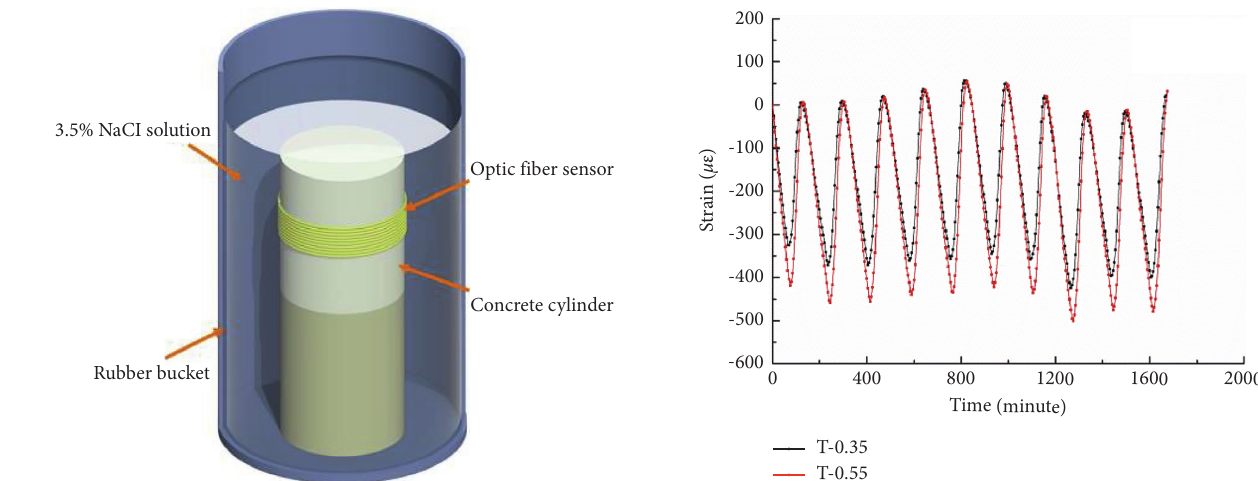
Figure 7: The strain behaviors of T-specimens.